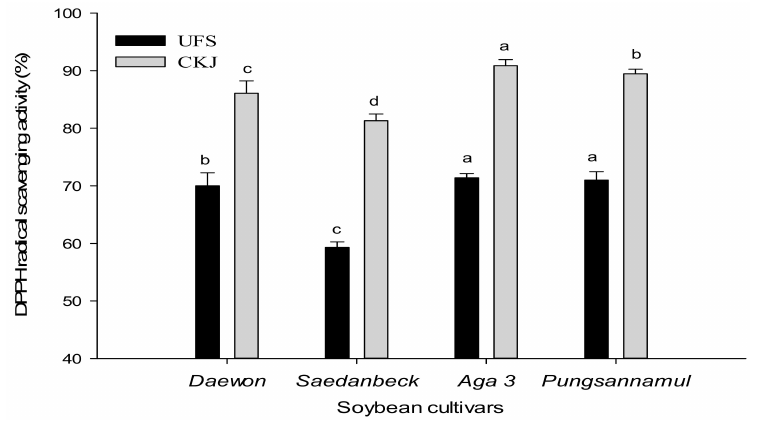
Figure 1. Changes in DPPH radical-scavenging activity between UFS and CKJ fermented by Bacillus subtilis (KCTC 13241) in different soybean cultivars. All values are means of three independent experiments. Means with different lowercase letters (a, b, c, and d) represent significant differences among cultivars by Duncan’s multiple range tests (DMRT) ( p <